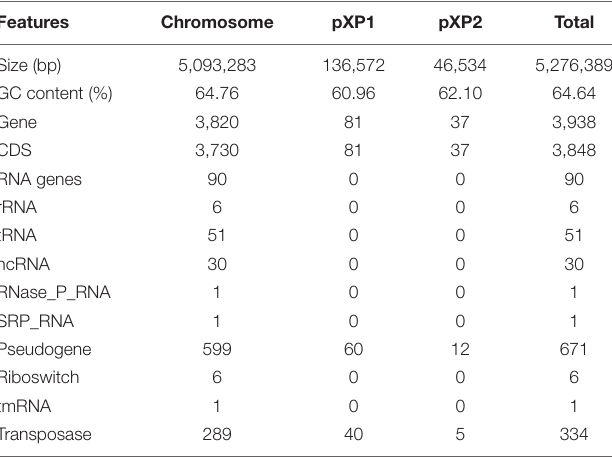
TABLE 1 | Genomic features of Xanthomonas perforans